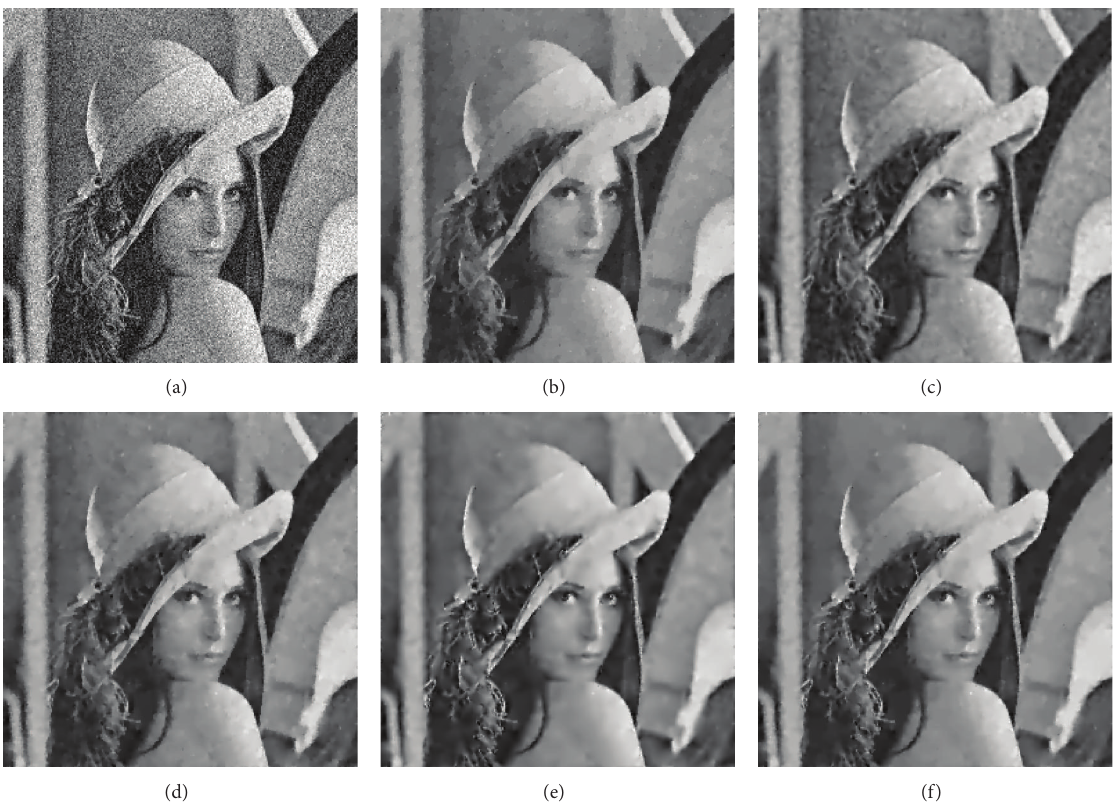
Figure 5: Results of different models for the image “Lena”: (a) the noisy image, the restored images by (b) the ROF model, (c) the LLT model, (d) the hybrid model, (e) our Model 1 ( 𝛼 = 0.26 and 𝑟 = 3 ), and (f) our Model 2 ( 𝛼 = 0.36 and 𝑟 = 3